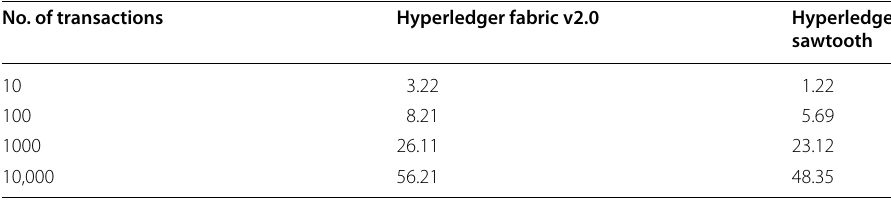
Table 5 Average latency—initialization process No. of transactions